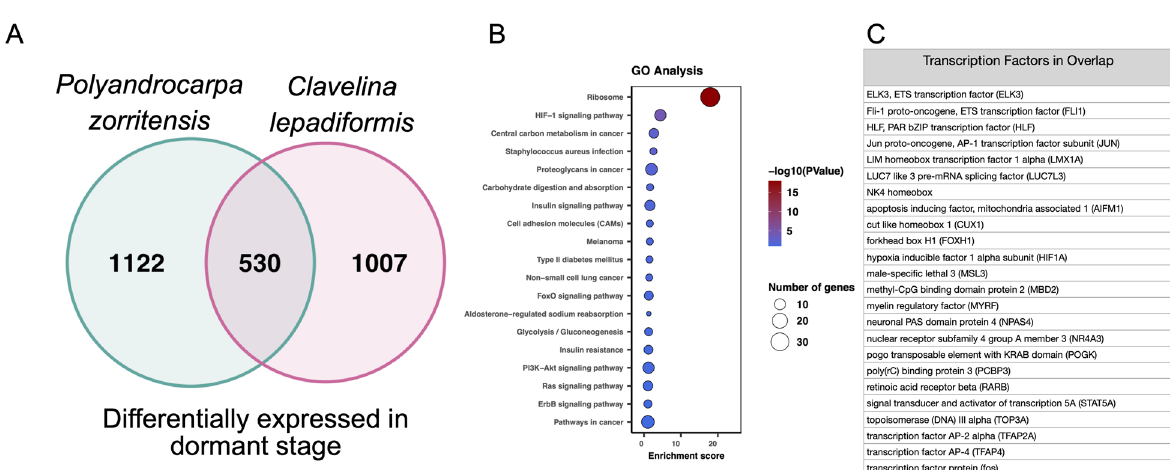
Figure 10. Shared up-regulated transcripts and pathways during dormancy in P. zorritensis and C. lepadiformis. ( A ) Venn diagram showing the number of orthologous upregulated transcripts during dormancy in P. zorritensis and C. lepadiformis . ( B ) KEGG pathway terms enriched in the overlapping set of 530 transcripts upregulated in both species. ( C ) Transcription factors upregulated in dormancy in both